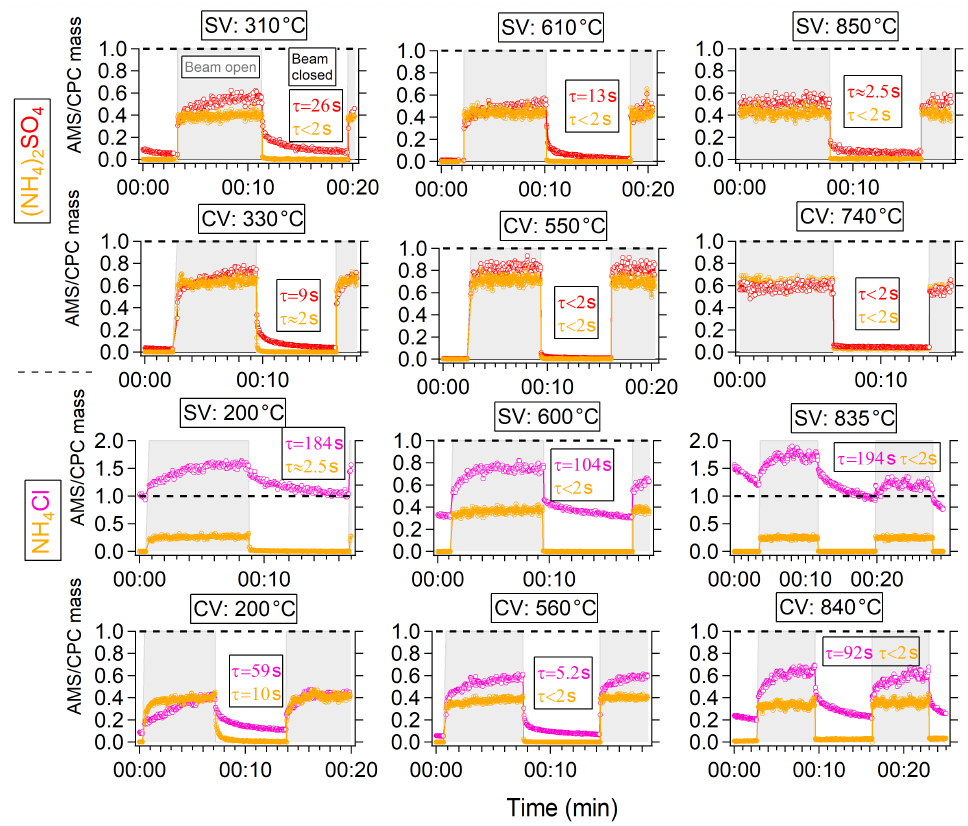
Figure 11. Results of an experiment with slowly alternating beam-open and beam-closed positions while sampling NaNO 3 and NH 4 Cl in the SV and CV. Note that the total signal (and not just the difference signal) is shown in all panels. The results from three or four different vapourizer temperatures (low, medium and high within the usable range) for each species are shown. τ is the lifetime of signal decay and was estimated through an exponential fit to the relevant part of the time series. τ for the rising signal is not shown, since it varies in the same